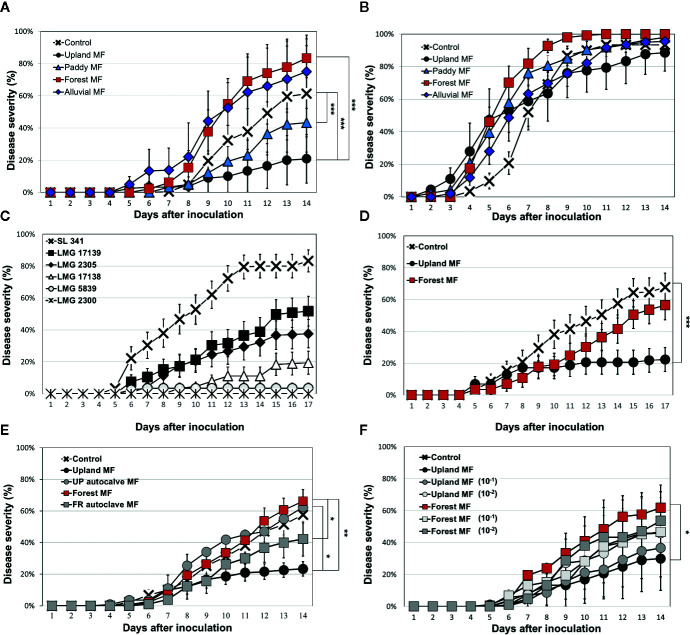
Bacterial wilt (BW) disease progression in tomato cultivars treated with soil microbial fractions (MFs) evaluated by ASPMI method. BW disease progression by R. solanacearum SL341 in the tomato cultivar Hawaii 7996 treated with four different soil MFs (A) and in the susceptible cultivar Moneymaker treated with soils MFs (B). BW disease progression in the Hawaii 7996 cultivar inoculated with six different R. solanacearum strains (C). Evaluation of BW disease progression by R. solanacearum LMG 17139 strain in Hawaii 7996 treated with upland soil MF or forest soil MF (D). Effect of heat-killed soil MFs (autoclave MF) (E) on BW disease progression in the Hawaii 7996 cultivar. Effect of diluted soil MF (F) on BW disease progression in the Hawaii 7996 cultivar (10−1, ten-fold diluted MF, 10−2, hundred-fold diluted MF). Control was treated with 2.5 mM MES buffer (pH 5.7). Each data point represents the mean disease incidence from three independent experiments. In total, 30 plants were analyzed for each treatment. Each vertical bar represents the standard error of the mean from three replicates (each replicate with 10 plants, n = 30). Significant difference was evaluated by repeated measure analysis of variance (ANOVA) (*p < 0.05; **p < 0.01; ***p < 0.001).